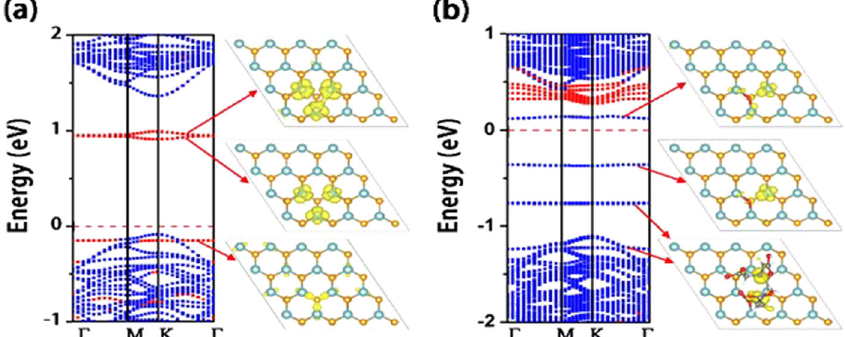
Fig. 5 The fi rst-principles calculations. The band structures and electron density of single-Se-vacancy SLM without a and with b the adsorption of EDTA. Yellow : electron density